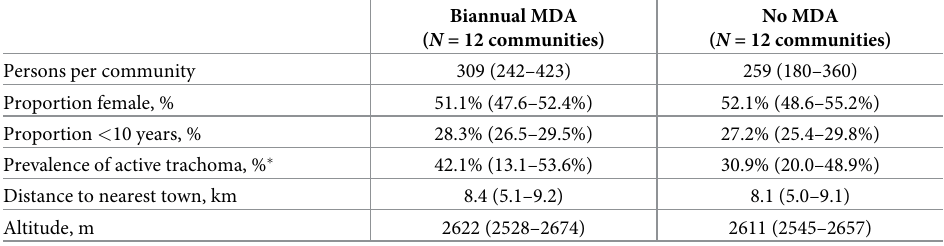
Table 1. Baseline characteristics of 24 communities randomized to either continuation or cessation of biannual mass azithromycin